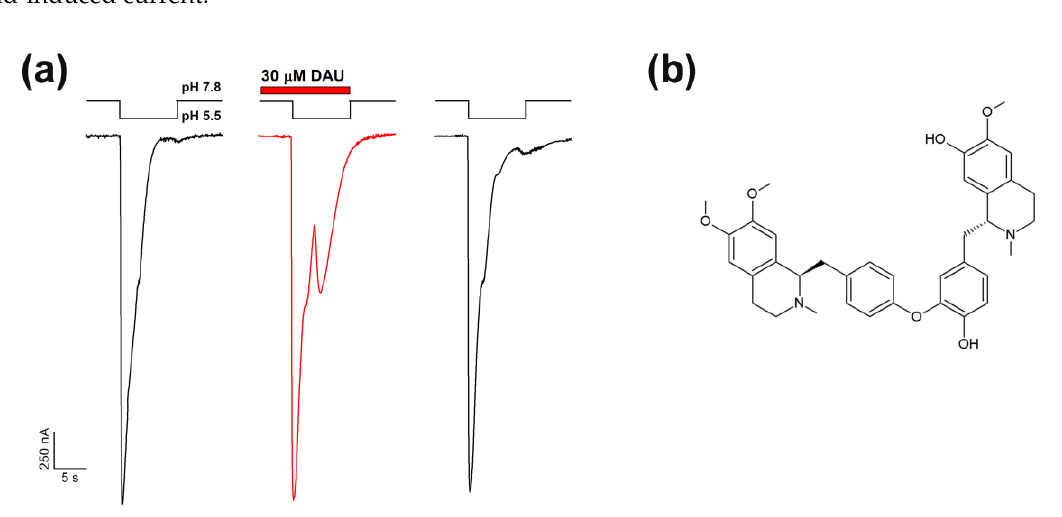
Figure 1. Effect of daurisoline (DAU) application on a rat ASIC1a channel and its structure. ( a ) Potentiating effect of DAU ( 30 μM) on ASIC1a channel activation by fast external solution acidification from pH 7.8 to 5.5. The whole-cell currents shown were obtained from the same oocyte. ( b ) Chemical formula of DAU.